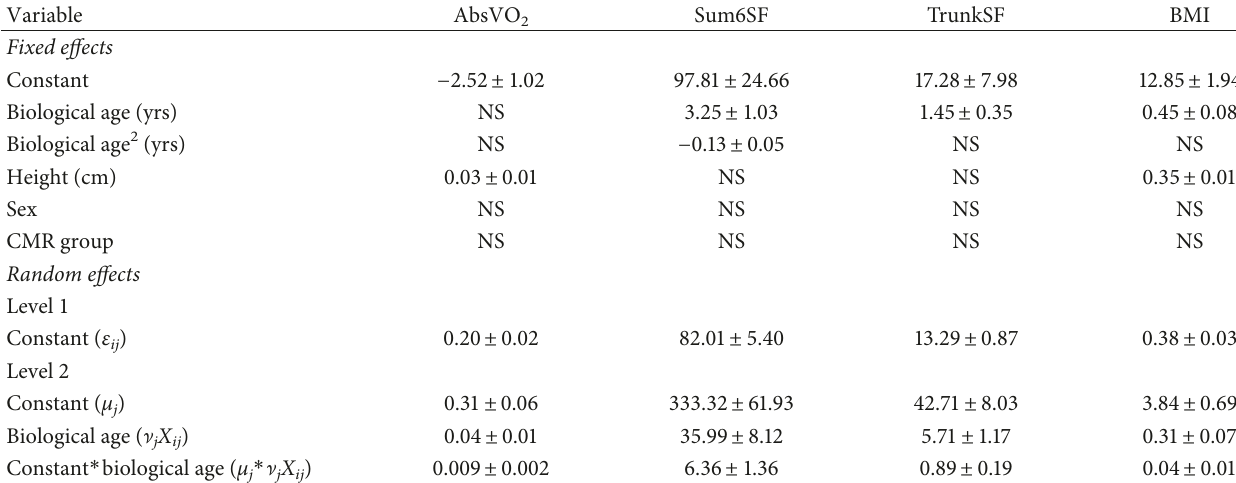
Table 2: Multilevel regression models for aerobic fitness, adiposity, and obesity status measures.